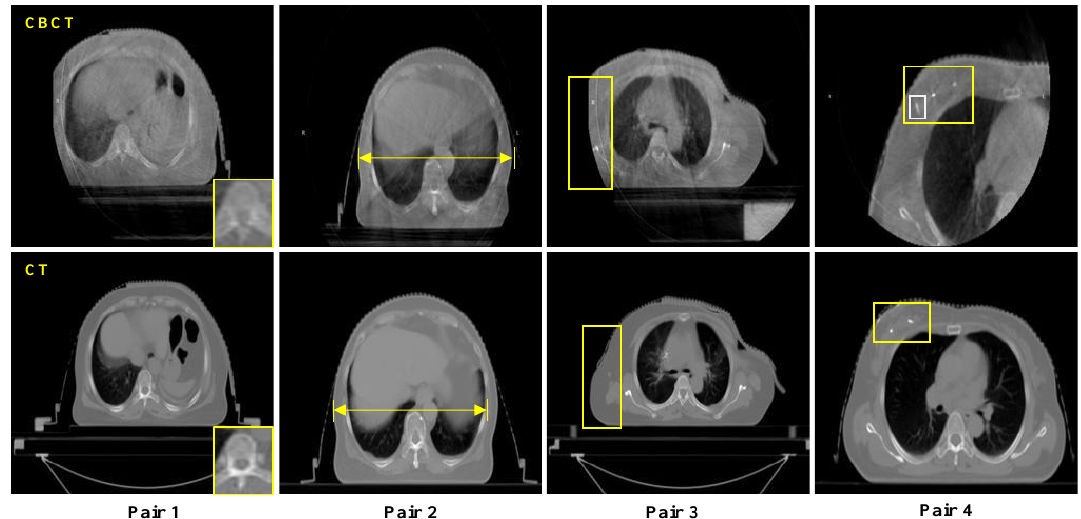
Figure 1. Typical imaging styles of CBCT and CT in IGRT (chest site).